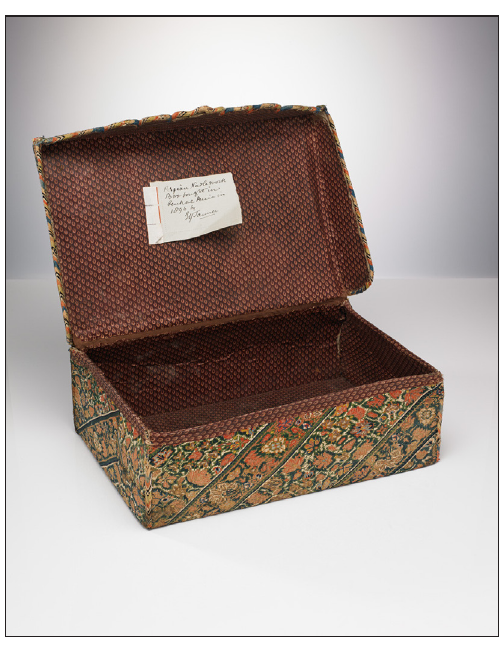
Fig. 13 : Needlework box, silk, cotton, paper, Iran, nineteenth century. T24, given by Miss E. G. Tanner in 1928. © Holburne Museum, Bath. Photo: